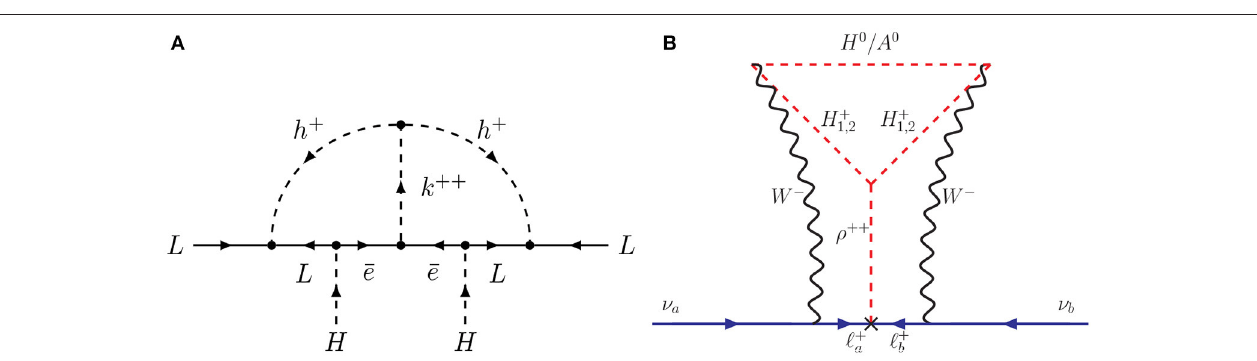
FIGURE 39 | (A) Feynman diagram for the generation of neutrino masses at two-loop order in the Zee-Babu model. (B) Feynman diagram at three-loop order in the cocktail model [518].